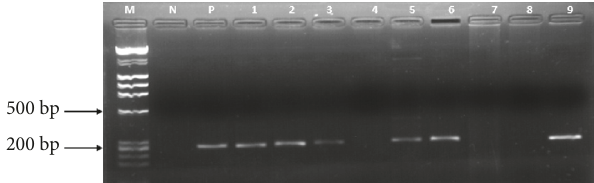
Figure 1: A 1% agarosegel showing the resolution of PCR amplicons generated using OIE recommended diagnostic primers for African swine fever virus. Lane M: 𝜆 DNA-Hind III and 𝜙 x174 DNA-Hae III mix (Finnzymes) molecular weight DNA marker, Lane N is a negative control, and Lane P is a positive control. Lanes 1, 2, 3, 5, 6, and 9 are selected positive samples with approximately 257 bp band size. Lanes 4, 7, and 8 are negative